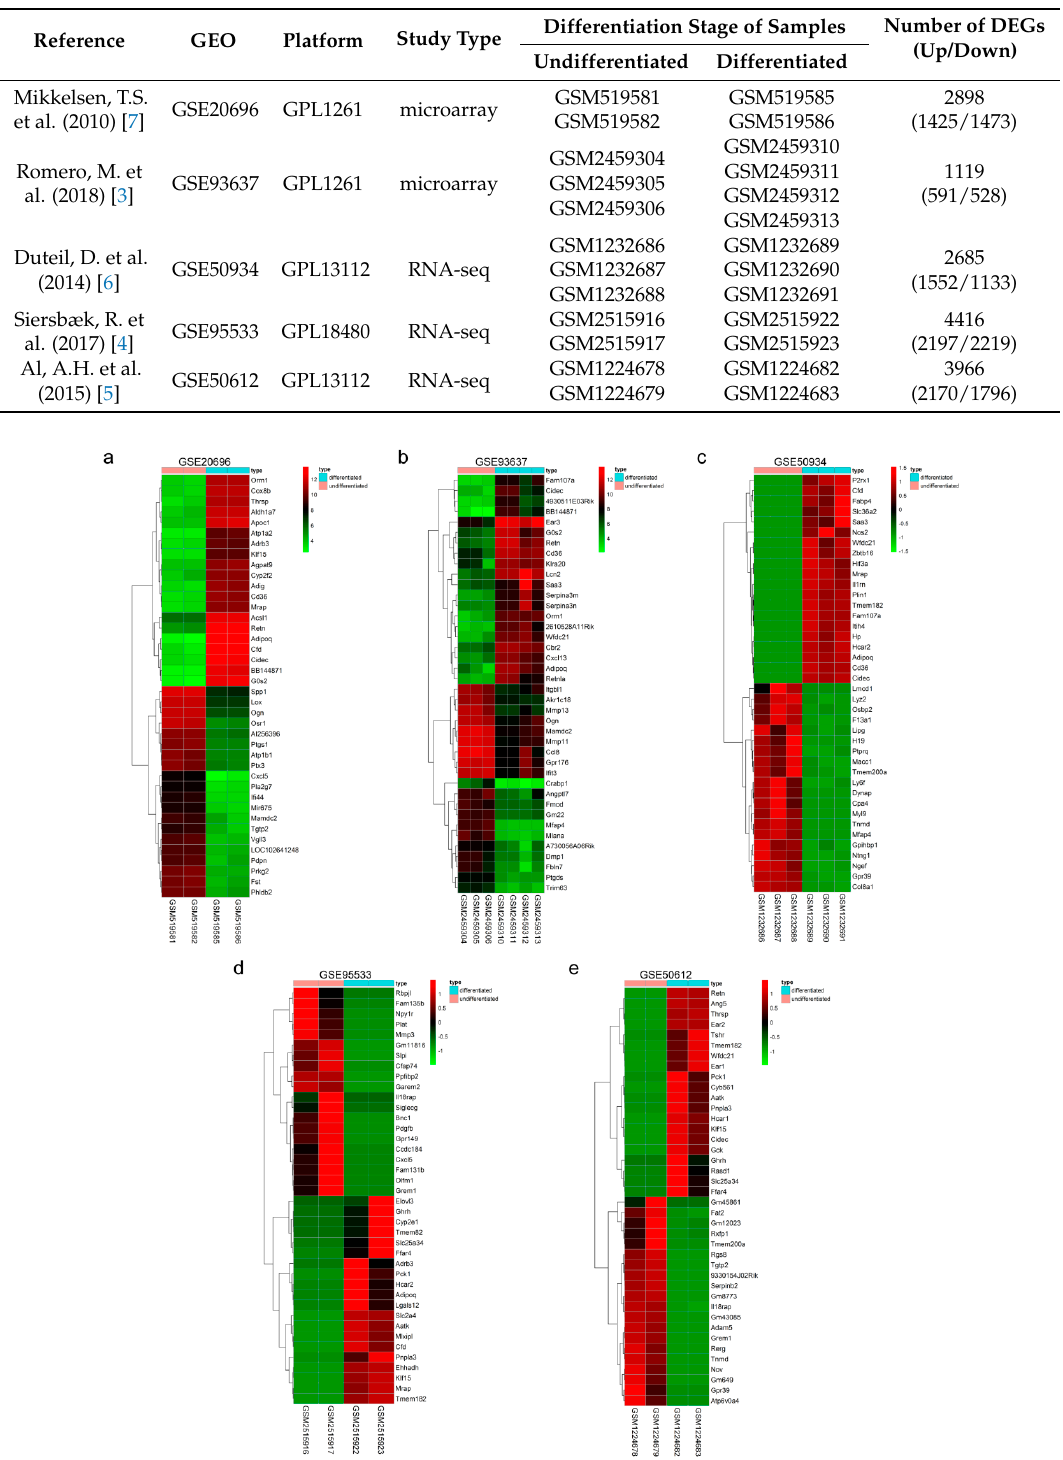
Table 1. Undifferentiated and differentiated 3T3-L1 cell samples from the NCBI Gene Expression Omnibus (GEO) database used in this study.